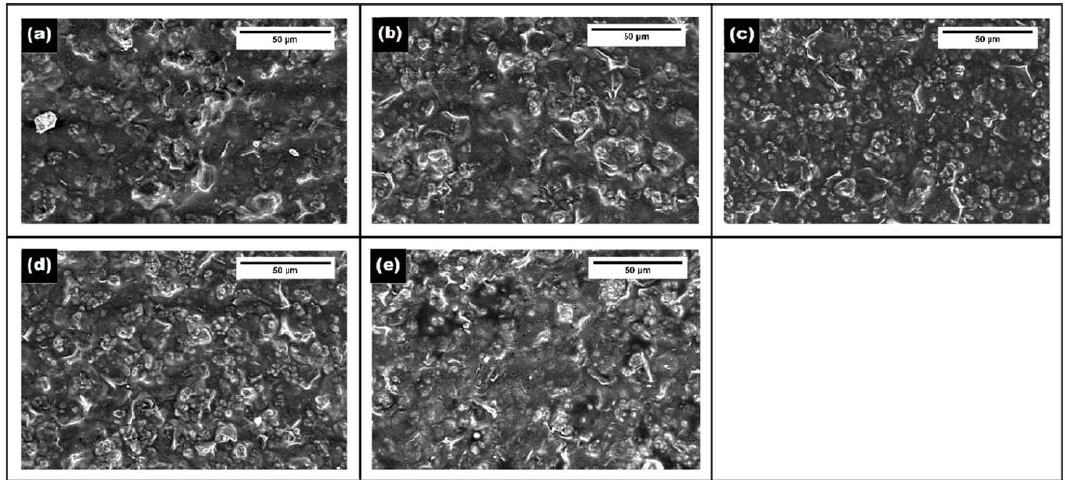
Figure 18. Environmental scanning electron microscopic images of tamarind gum film and geraniol (GER) containing films. Films with different GER content (w/w) ( a ) 0 %, ( b ) 0.5 %, ( c ) 1.0 %, ( d ) 2.0 % and ( e ) 3.0 %. Reproduced with permission from [24]. Copyright 2020 Elsevier.